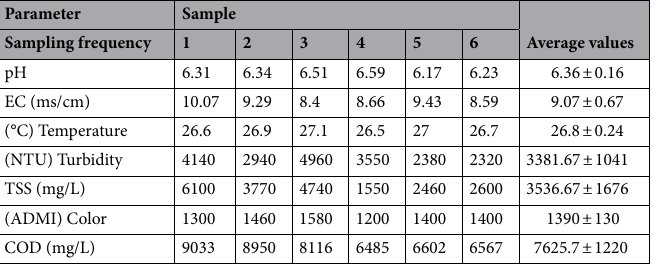
Table 2. Characteristics of RPCM raw wastewater. RPCM, recycled paper and cardboard mill.